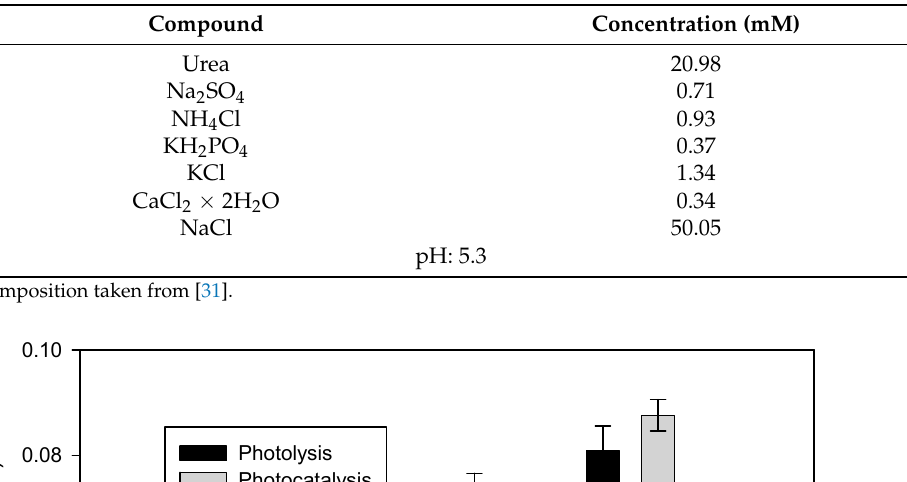
Table 3. Composition of the simulated hospital wastewater (HWW) 1 .